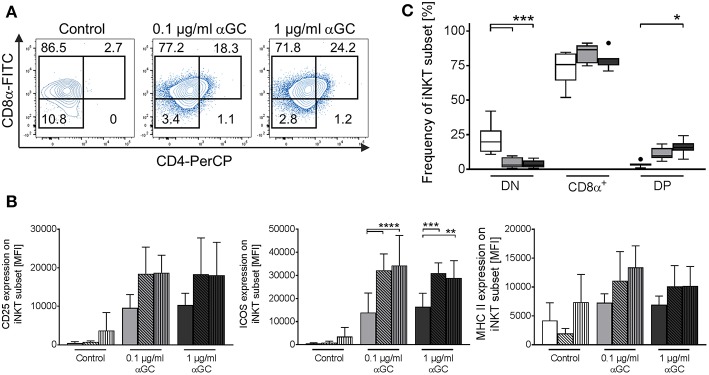
Changes in iNKT cell subset frequency upon antigenic activation. Porcine PBMC were incubated in the presence of of 0.1 μg/ml or 1 μg/ml αGC or DMSO as vehicle control for 4 days. (A) Expression of CD8α and CD4 on iNKT cells was investigated. Representative flow cytometric plots of controls (left plot), low-dose (middle plot), and high-dose αGC (right plot) stimulated iNKT cells are shown. CD8α−/CD4− (DN), CD8α+/CD4− (CD8α+), and CD8α+/CD4+ (DP) subsets in iNKT cells were identified as previously shown. Numbers in the plot show the frequencies of the respective gate. (B) Frequency of iNKT cell subsets in controls (white) and after stimulation with 0.1 μg/ml (gray) or 1 μg/ml αGC (black) shown as Tukey box plots (n = 7). (C) Expression level of CD25 (left graph), ICOS (middle graph), and MHC II (right graph) on DN (empty bars), CD8α+ (diagonal black hatching), and DP (vertical black stripes) iNKT cells was investigated in control cells (white) and cells stimulated with 0.1 μg/ml (gray) or 1 μg/ml (black) αGC (mean (SD), n = 4). *p < 0.05, **p < 0.01, ***p < 0.001, ****p < 0.0001, repeated-measures one-way ANOVA with Holm-Sidak's post-hoc test for multiple comparisons.